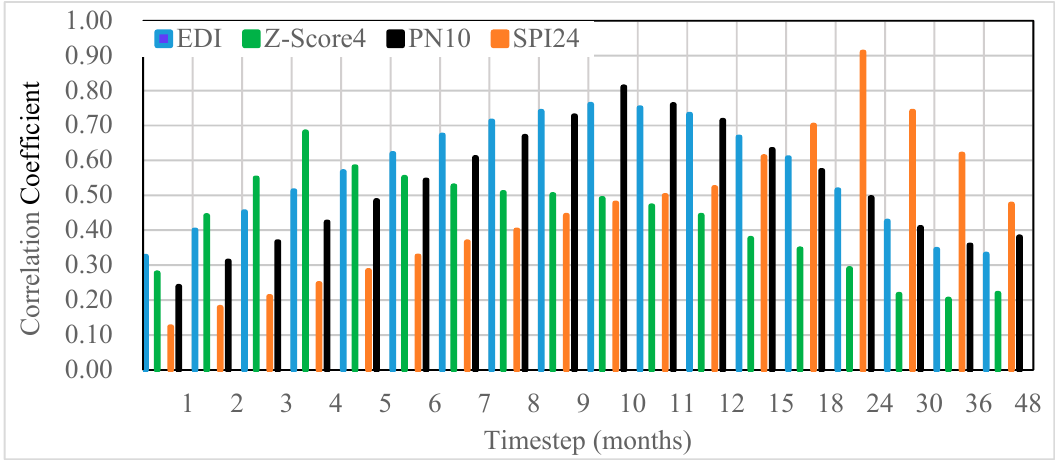
Figure 3. Average correlation coefficient of representative DIs with short (Z-Score4), intermediate (PN10), and long timesteps (SPI24) against other DIs for each timestep.